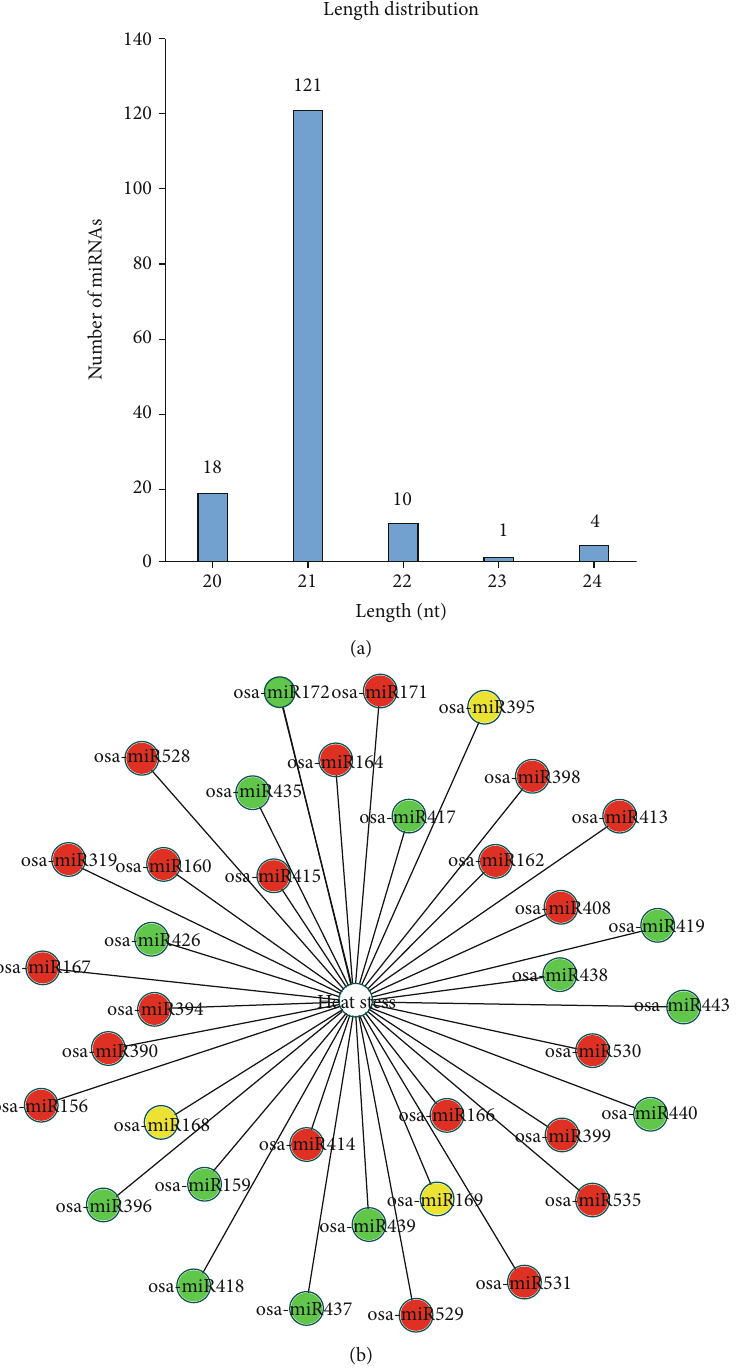
Figure 2: Classi fi cation of DE-miRNAs in rice under the heat stress. (a) The length distribution of 124 DE-miRNA sequences. (b) Bipartite network visualization of the regulatory relationship between DE-miRNA families and heat stress in rice. The links between heat stress and miRNA families indicate involvements between miRNA families in the regulation of heat response. The solid red, green, and yellow circles denote upregulated, downregulated, and up-/downregulated expression patterns of miRNA families under the heat stress,